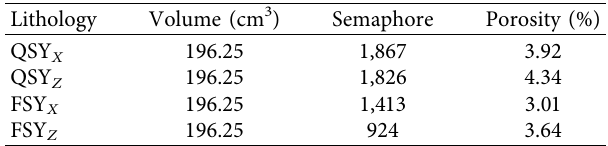
Table 1: Nuclear magnetic porosity test results of sandstone with different pores.